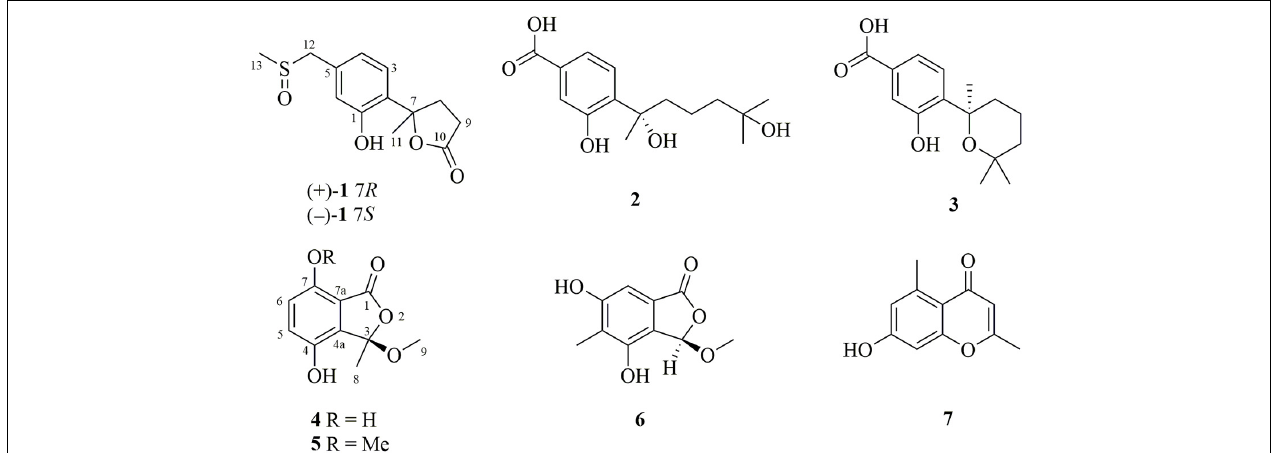
FIGURE 1 | Chemical structures of the isolated compounds 1–7 from P. chrysogenum LD-201810.